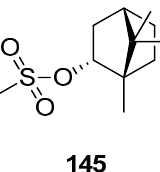
Figure 42. (–)-Borneol derivative, 1,7,7-trimethylbicyclo[2.2.1]hept-2-yl methane sulfonate as antibacterial agent.